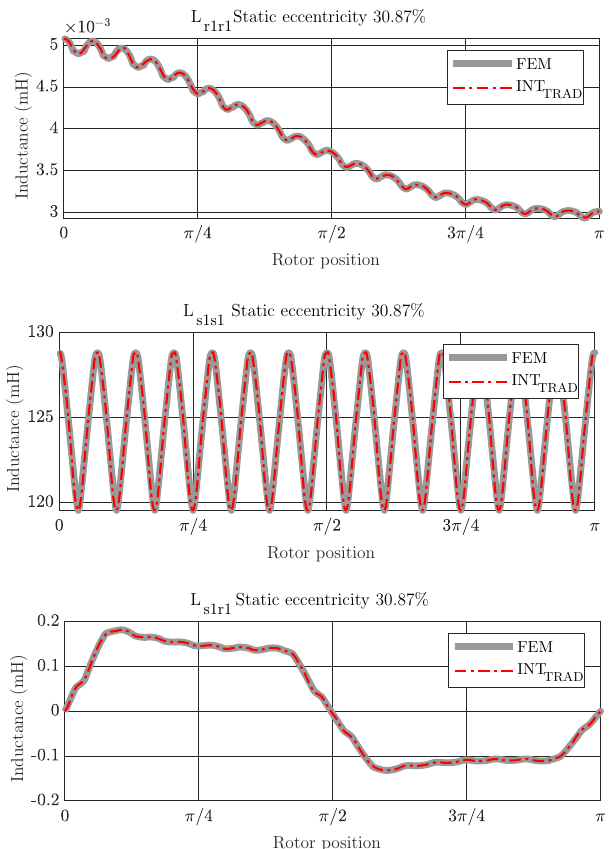
Figure 9. Coupling parameters between rotor bar 1 and itself ( top ), between stator phase 1 and itself ( middle ) and between stator phase 1 and rotor bar 1 ( bottom ), depending on the rotor position using FEM simulations and traditional trigonometric interpolation polynomial for 30.87% of static eccentricity. Both methods obtain essentially the same values as